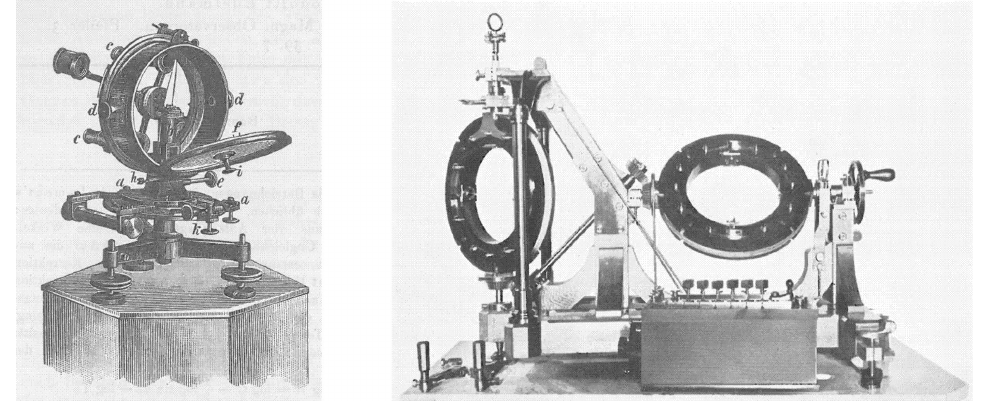
Figure 6. Sketch of the dip needle by Carl Bamberg, Friedenau, near Berlin (left), and the Earth inductor after Leonhard Weber (right). Source: left – Eschenhagen (1894), right – Hellmann (1912).